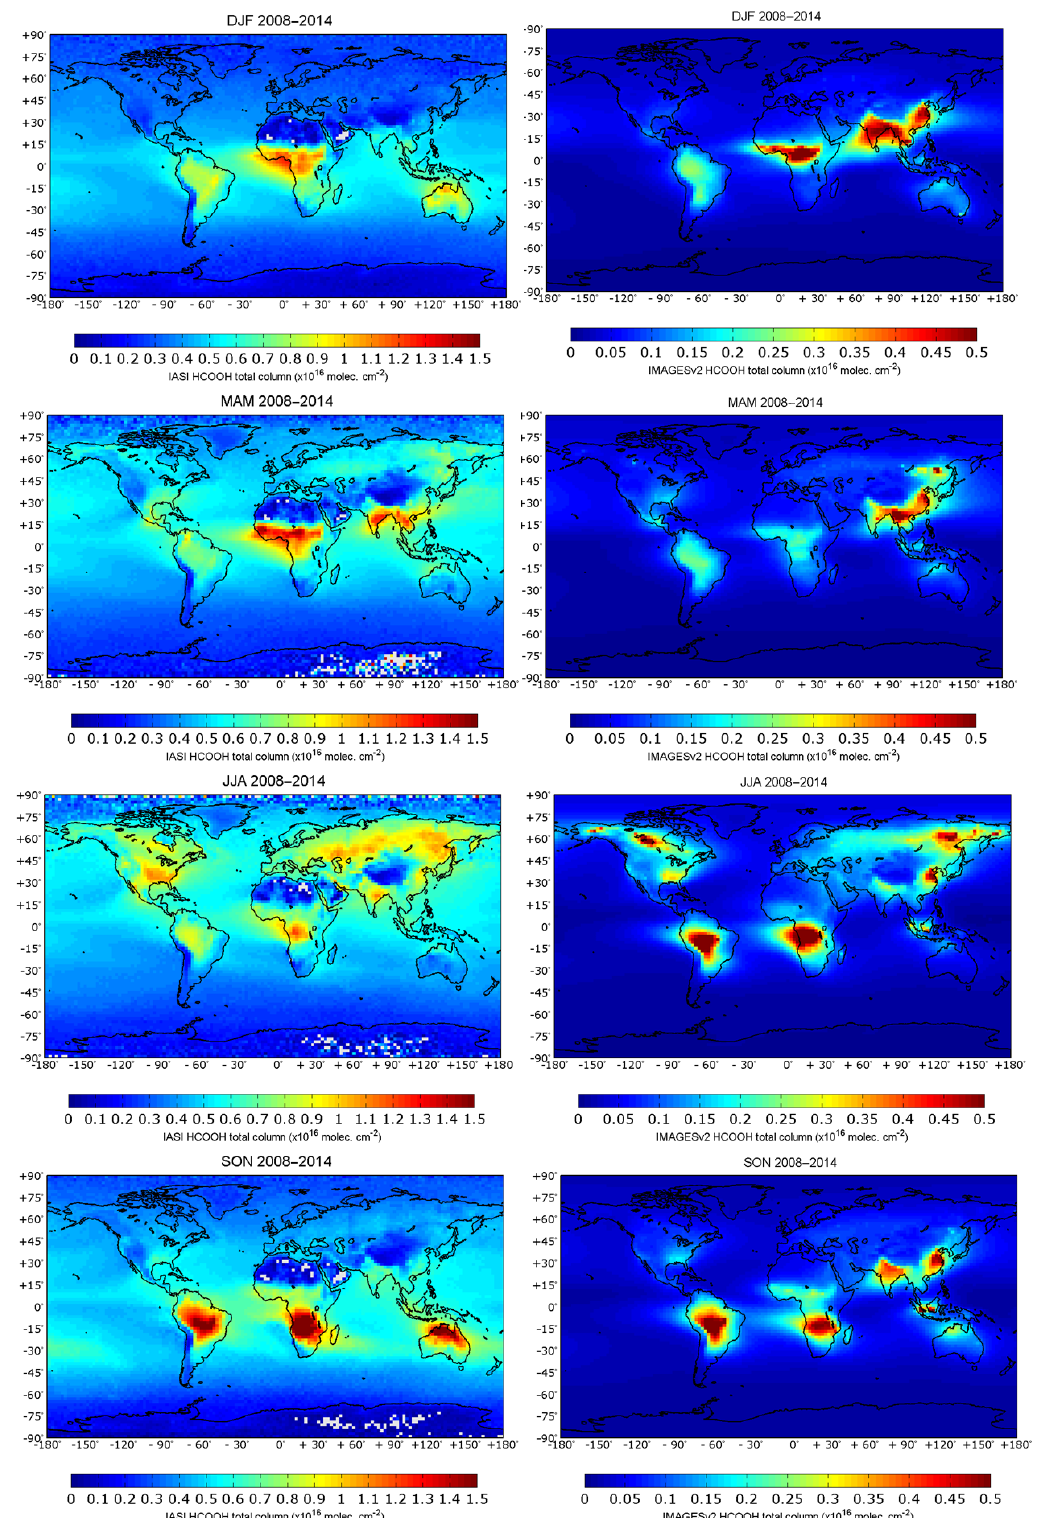
Figure 12. Seasonal HCOOH global distribution from 2008 to 2014 derived using the IASI radiance observations, gridded to IMAGESv2 horizontal resolution (2 ◦ lat × 2.5 ◦ long) (left panel), and from IMAGESv2 (right panel). DJF is December–January–February; MAM is